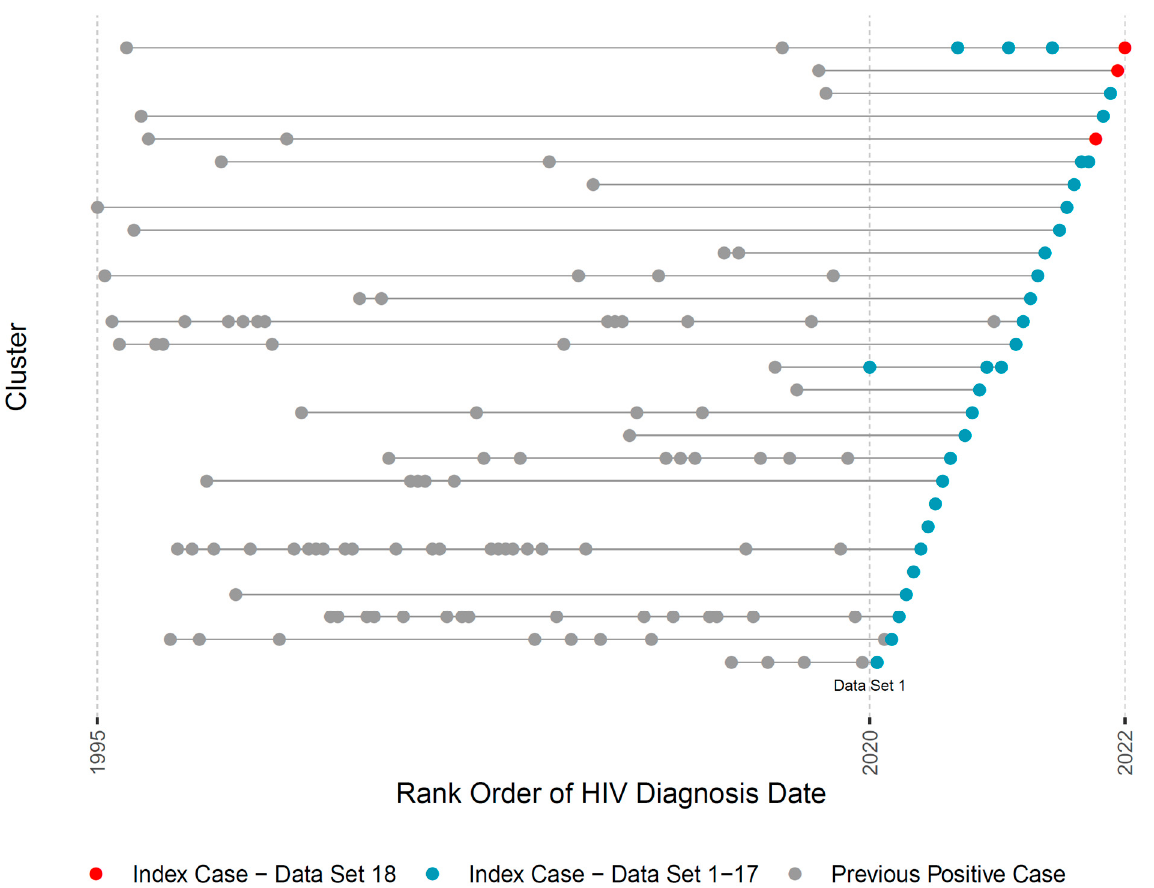
Figure 3. Title: Visual representation of HIV cluster growth in RI. Legend: This figure illustrates one visual output of the automated pipeline that is used in monthly academic-public health case management discussions. Each row represents one cluster’s lifespan according to years of HIV diagnosis of its members (X axis). Red dots indicate new index HIV cases in the current month. Blue dots indicate new HIV index cases in the prior 18 datasets. Gray dots indicate cluster members who were diagnosed prior to the start of the study. For patient privacy concerns, we use the rank ordering of diagnosis dates instead of the exact dates.